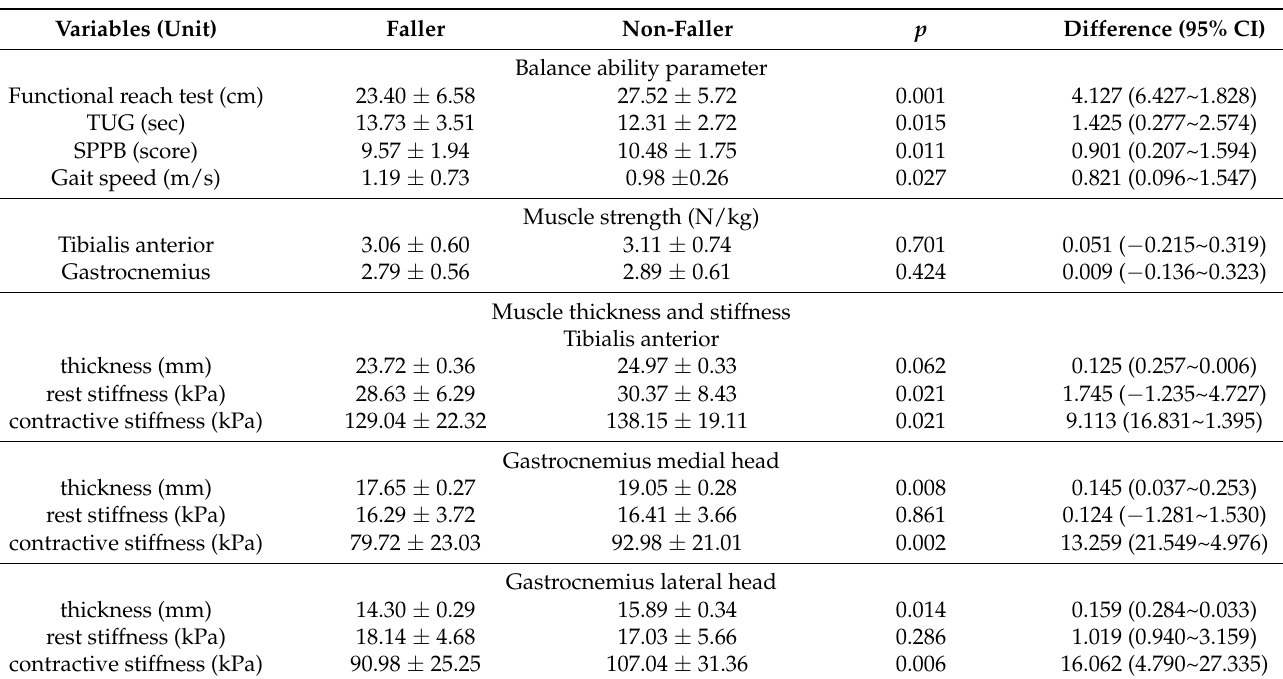
Table 2. Comparison of balance ability, muscle strength, and muscle thickness and stiffness in the fallers and non-fallers.